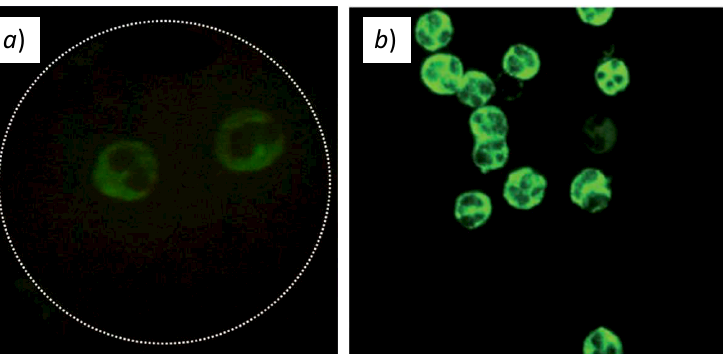
Figure 13. Fluorescence images of granules in neutrophil cytoplasm labeled with FITC fluorophore obtained with ( a ) our inverted fluorescence microscope; ( b ) a commercial Motic BA410E fluores- cence